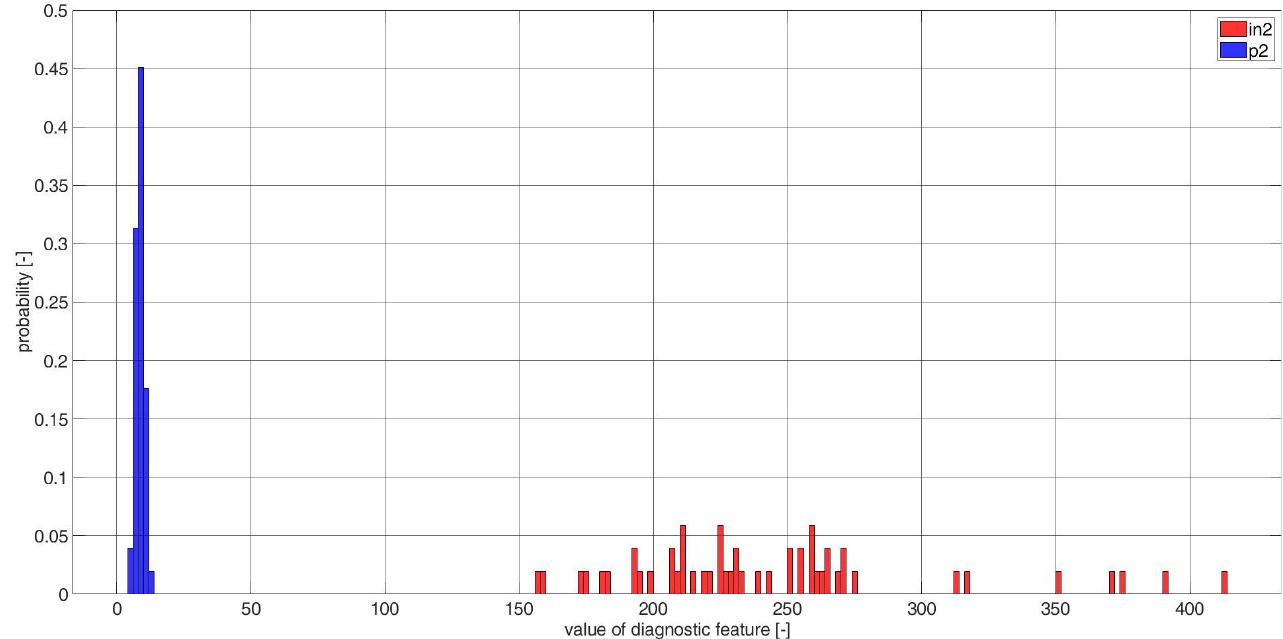
Figure A7. Histograms of diagnostic features based on the CCSM3 (correlation number is 7—Table A1) bearings in1 and p1.